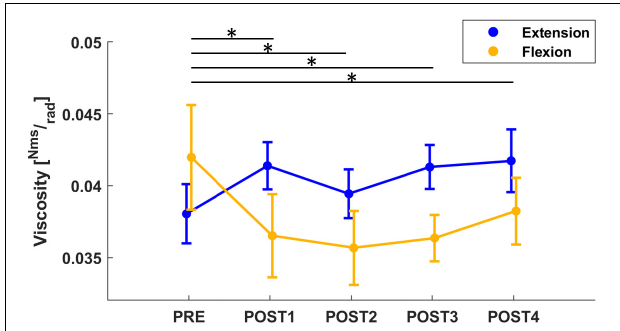
FIGURE 4 | The mean and standard error of wrist viscosity, calculated in both flexion (yellow) and extension (blue) directions. Viscosity computed in flexion significantly decreased from PRE to all post-fatigue assessment sessions (the significant results after post-hoc analysis, marked with “ ∗ ”, refer to the flexion viscosity: yellow line), whereas viscosity in extension showed an increasing tendency after fatigue.